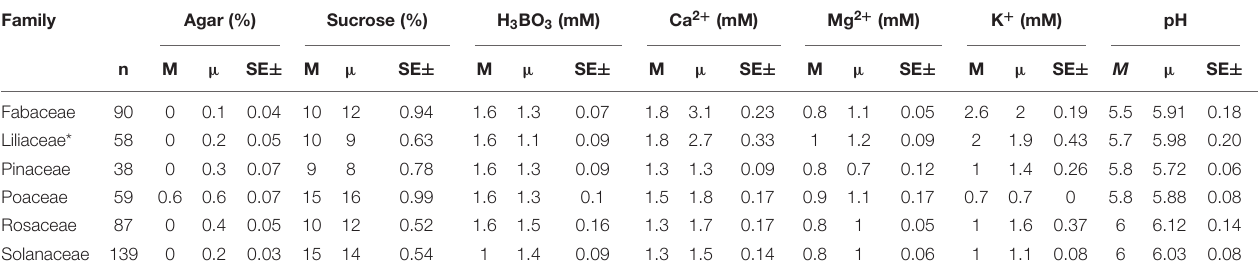
TABLE 3 | The median (M), mean ( µ ) concentrations, and standard error of the most frequently used ingredients in in vitro pollen germination media for the most represented families.